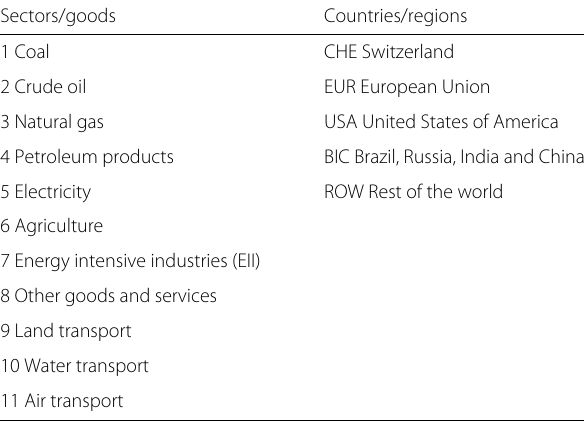
Table 1 Industrial and regional